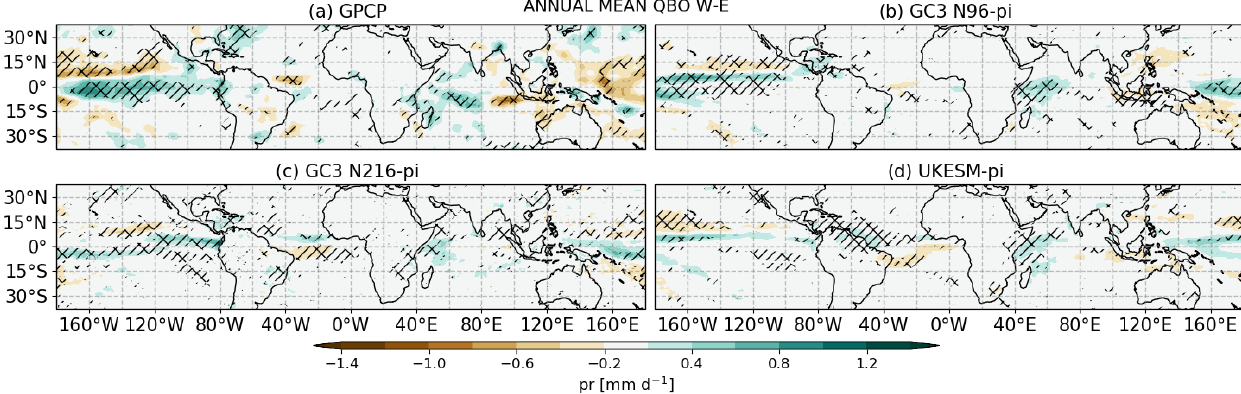
Figure 1. QBOW minus QBOE composite differences in annual-mean precipitation [mmd − 1 ] from (a) GPCP, (b) GC3 N96-pi, (c) GC3 N216-pi and (d) UKESM N96-pi. Hatching denotes statistically significant differences at the 95% confidence level.